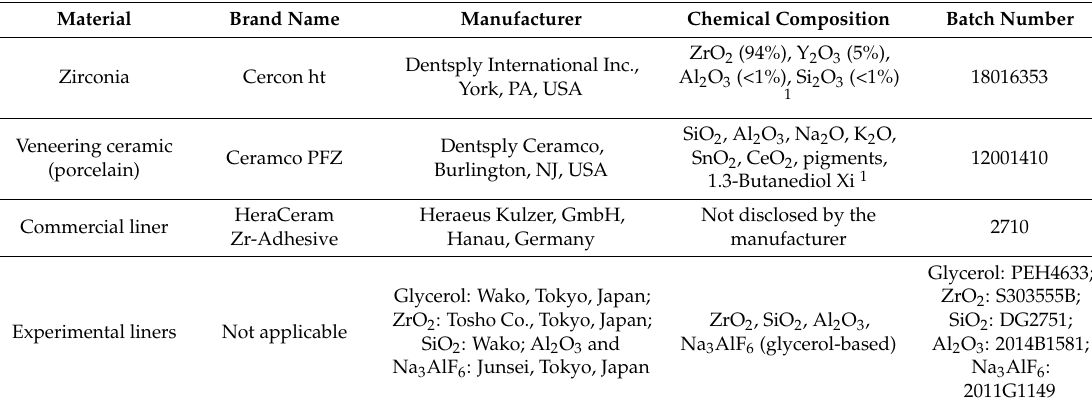
Table 1. Ceramic materials used in this study.